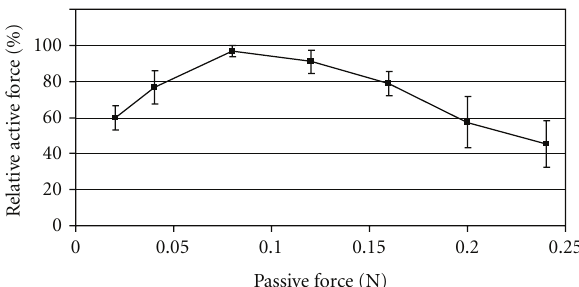
Figure 3: The active force generated by the SM muscle as a function of passive tension, with which the muscle was stretched just before stimulation. The active force was produced by the SM muscle in response to electrical stimulation of the SM nerve. A 200 ms train of 1mA biphasic pulses at 200 pulses/s was used. Each phase of biphasic pulse lasted 0.2 ms. Data shown in this graph represent average active force, normalized by maximal force (observed at 0.08N tension). Vertical bars represent standard error. The SM muscle was denervated for 3 months, repaired by end-to-end anastomosis, and left to recover for additional 3 months. The same muscle force-tension characteristic was observed in the noninjured control muscles [18].